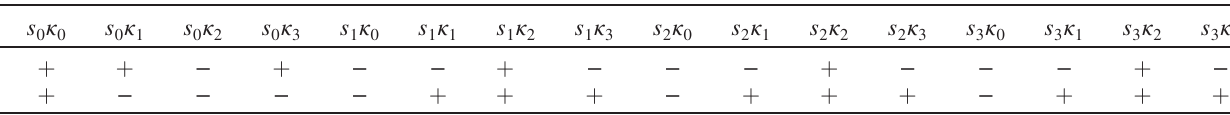
TABLE I. The constraints of time reversal symmetry ( Θ ) and particle-hole symmetry ( P ) on the 16 s þ ( − ) to label the matrices satisfying U s i κ j U − 1 ¼ s i κ j ( U s i κ j U − 1 ¼ − s i κ j ), with U being Θ or P .